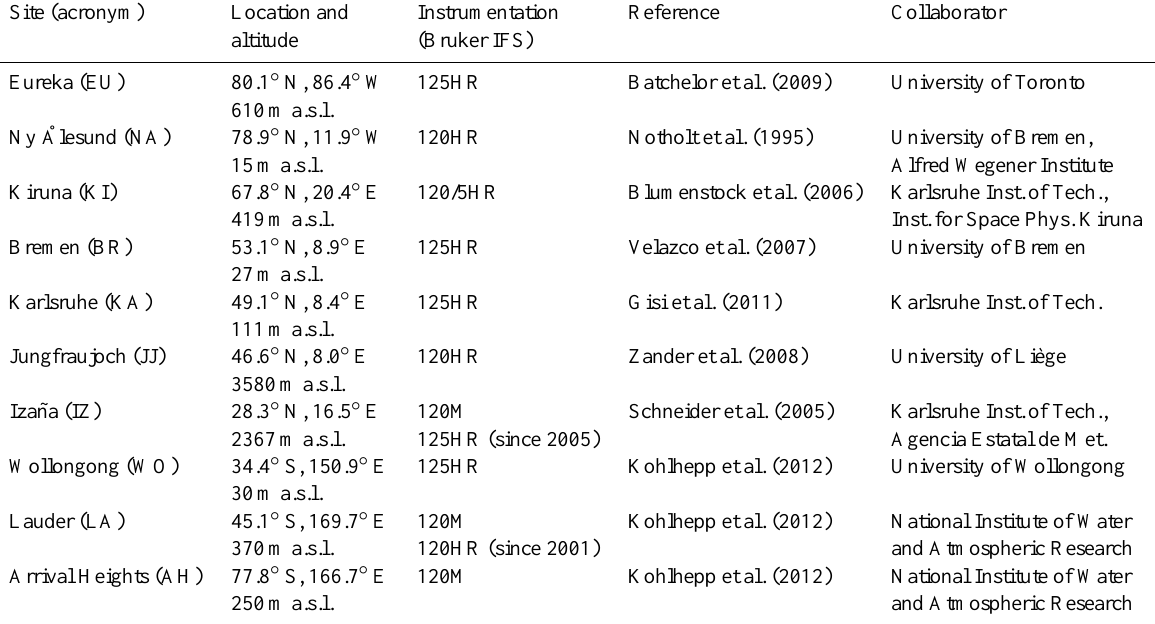
Table 1. List of the ten initial ground-based FTIR MUSICA